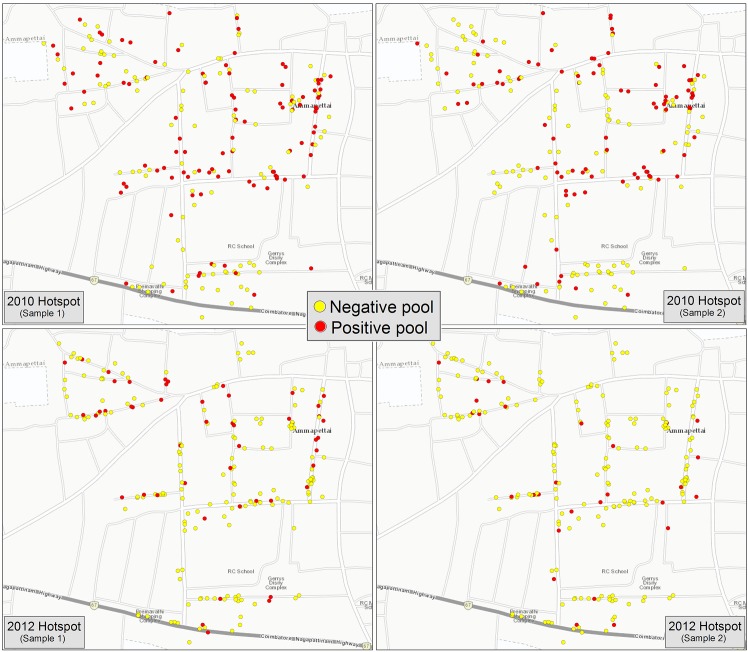
Map of positive and negative pools by household location in the Hotspot evaluation unit, 2010 and 2012.